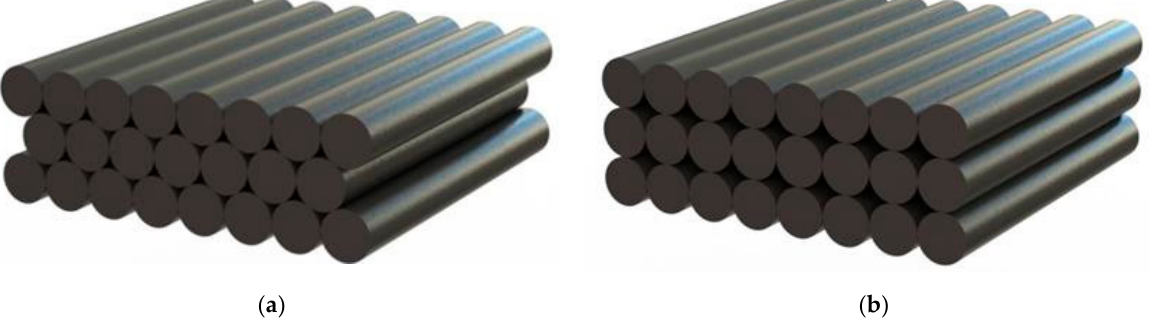
Figure 4. A staggered ( a ) and in-line ( b ) arrangement of the samples.